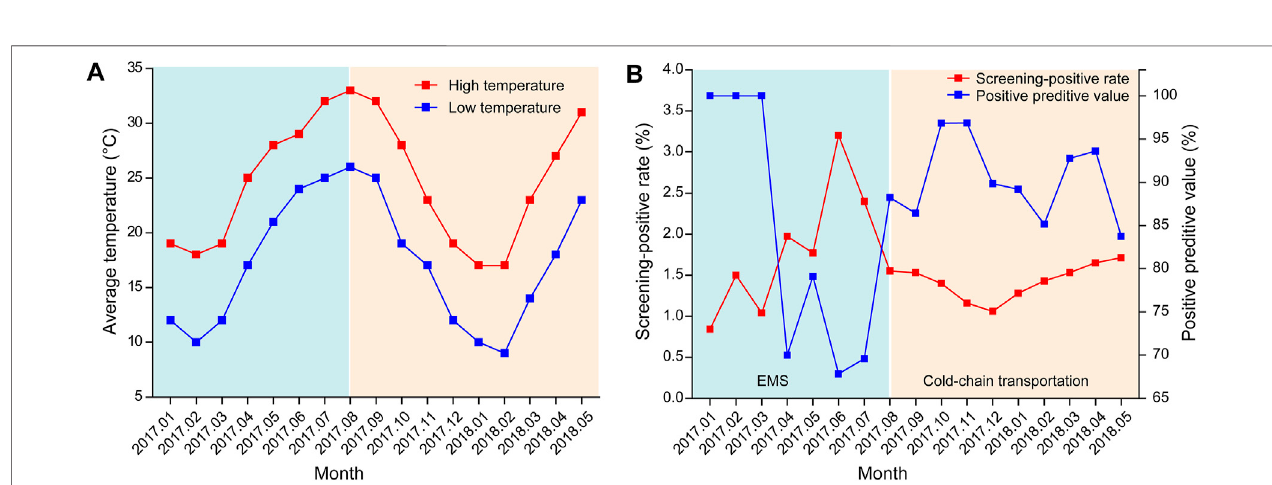
FIGURE6| Effectoftemperatureonthescreeningaccuracy (A) MonthlyaveragetemperatureinXiamenfromJanuary2017toMay2018(datawereobtainedfrom https://www.tianqi.com/xiamen/). (B) Screening-positiverates and positive predictive valuesof newborn screening from January 2017toMay 2018. EMS, express mail